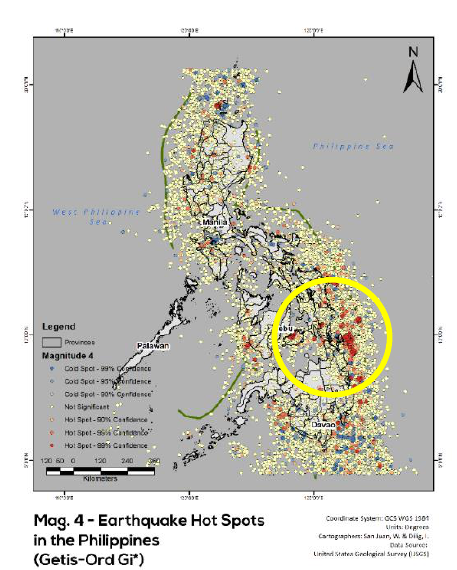
Figure 6. Mag.4-Earthquake Hot Spots in the Philippines